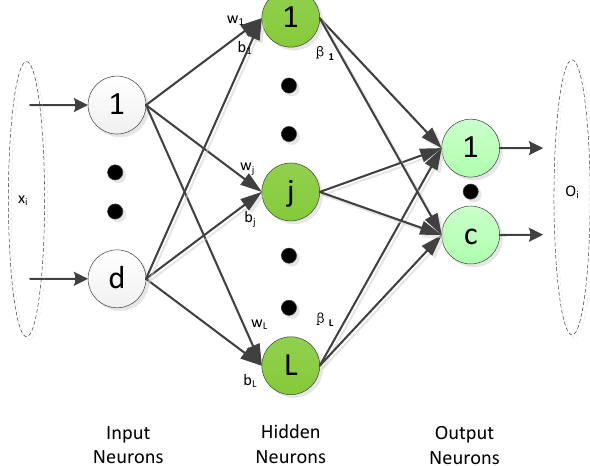
Figure 2. The architecture of the Extreme Learning Machine (ELM). In detail, it is a single-hidden layer feed-forward network with three parts: input neurons, hidden neurons and output neurons. In particular, h ( x ) = [ h 1 ( x ) ,..., h L ( x )] is nonlinear feature mapping of ELM with the form of h j ( x ) = g ( w j . x + b j ) and β j = [ β j 1 ,..., β jc ] T , j = 1,..., L is the output weights between the j th hidden layer and the output